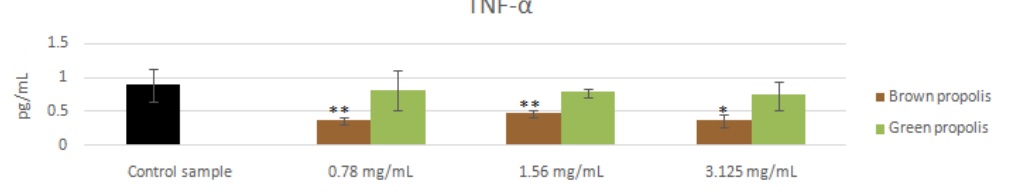
Figure 8. TNF ‐α levels in HaCat cells treated with increasing concentrations of brown propolis extract (0.78–3.125 mg/mL). * Indicates statistically significant differences ( p < 0.05) between treated and untreated cell cultures as reported in the text. ** Indicates statistically significant differences ( p < 0.01) between treated and untreated cell cultures as reported in the text.